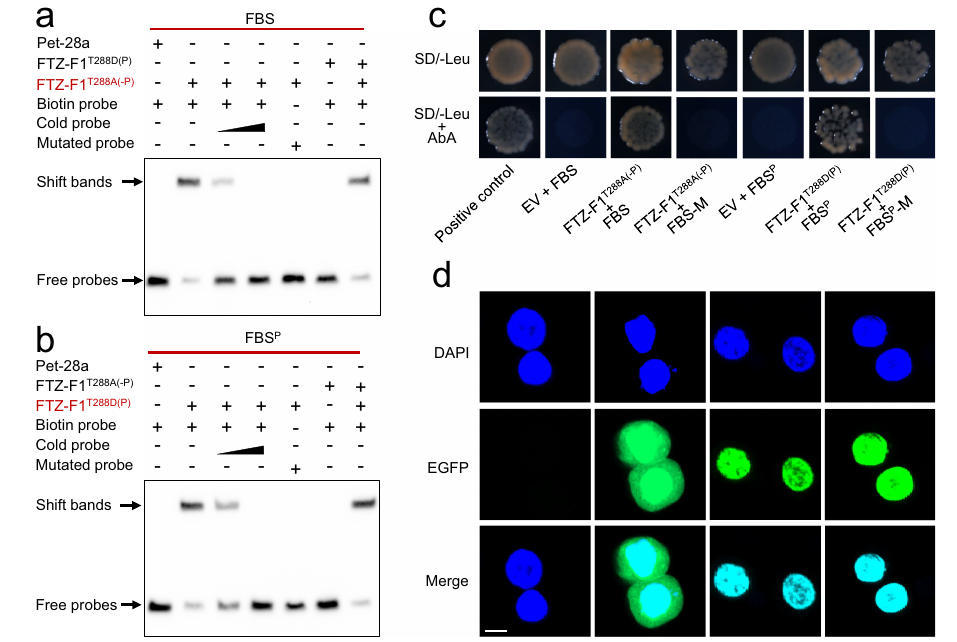
Fig. 4 | Phosphorylated and non-phosphorylated FTZ-F1 preferentially bind to distinct DNAmotifsand both functionin thenucleus.a , b EMSAassayvalidates thatthenon-phosphorylatedFTZ-F1 T288A(-P) ( a )andthephosphorylatedFTZ-F1 T288D(P) ( b )speci fi callybindtotheFBS( a ),andFBS P ( b )respectively.Theconcentrationsof the wild-type and mutant probes were 20fmol; the concentrations of competing cold probes were 100 and 500fmol. The mutant sequences were 5 ′ -CGCACA- CACGT − 3 ′ for FBS and 5 ′ -GGCTCCGAAC-3 ′ for FBS P . c Y1H assays verifying the